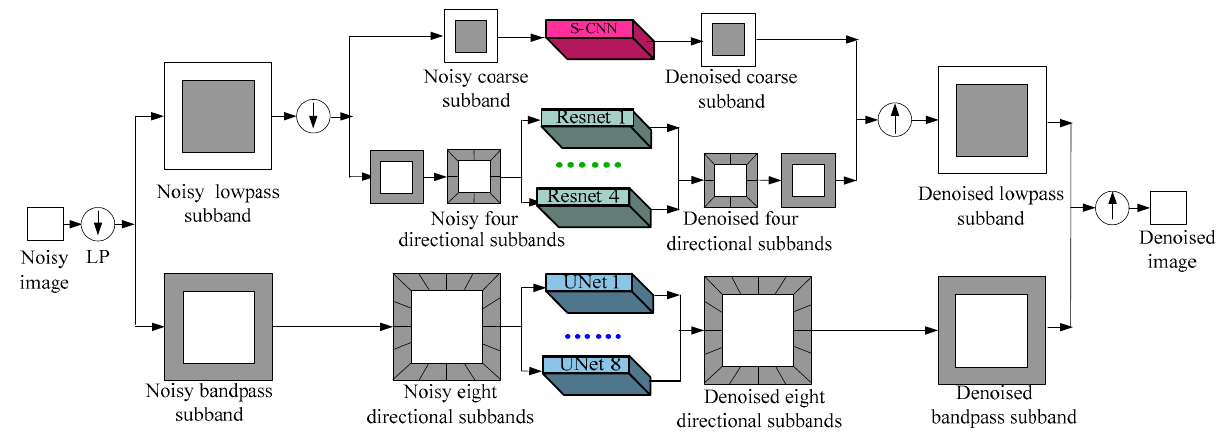
Figure 1. The Contourlet convolutional neural network (CCNN) architecture.